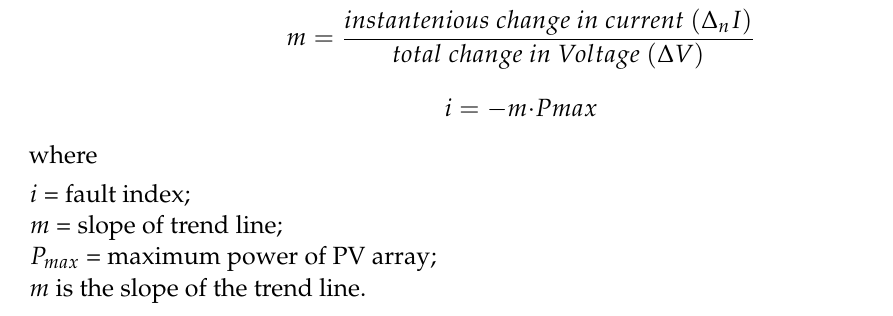
Figure 2. Pictorial view of the experimental setup of 5 kW.